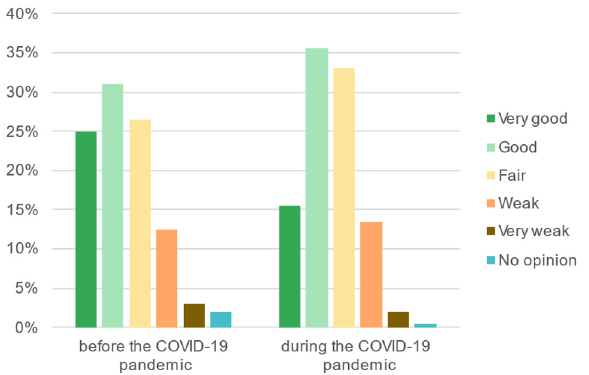
Figure 9. Rating the accessibility of recreation areas before and during the COVID-19 pandemic.